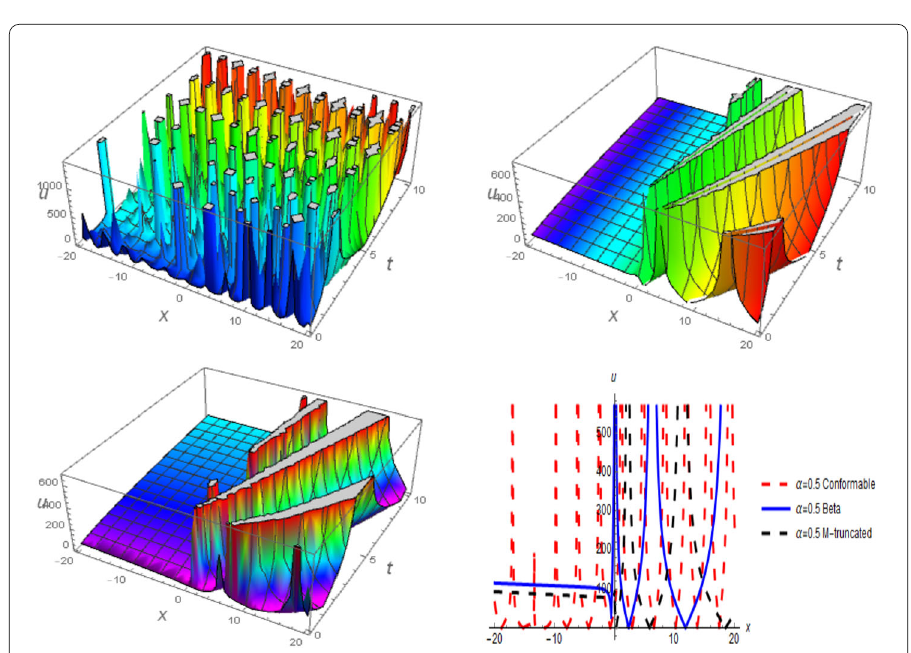
Figure 6 ( a ) 3D-plot of u 8 for conformable, ( b ) 3D-plot of u 8 for beta with α = 0.5. ( c ) 3D-plot of u 8 for conformable, ( d ) 2D-plot of u 8 with t = 1